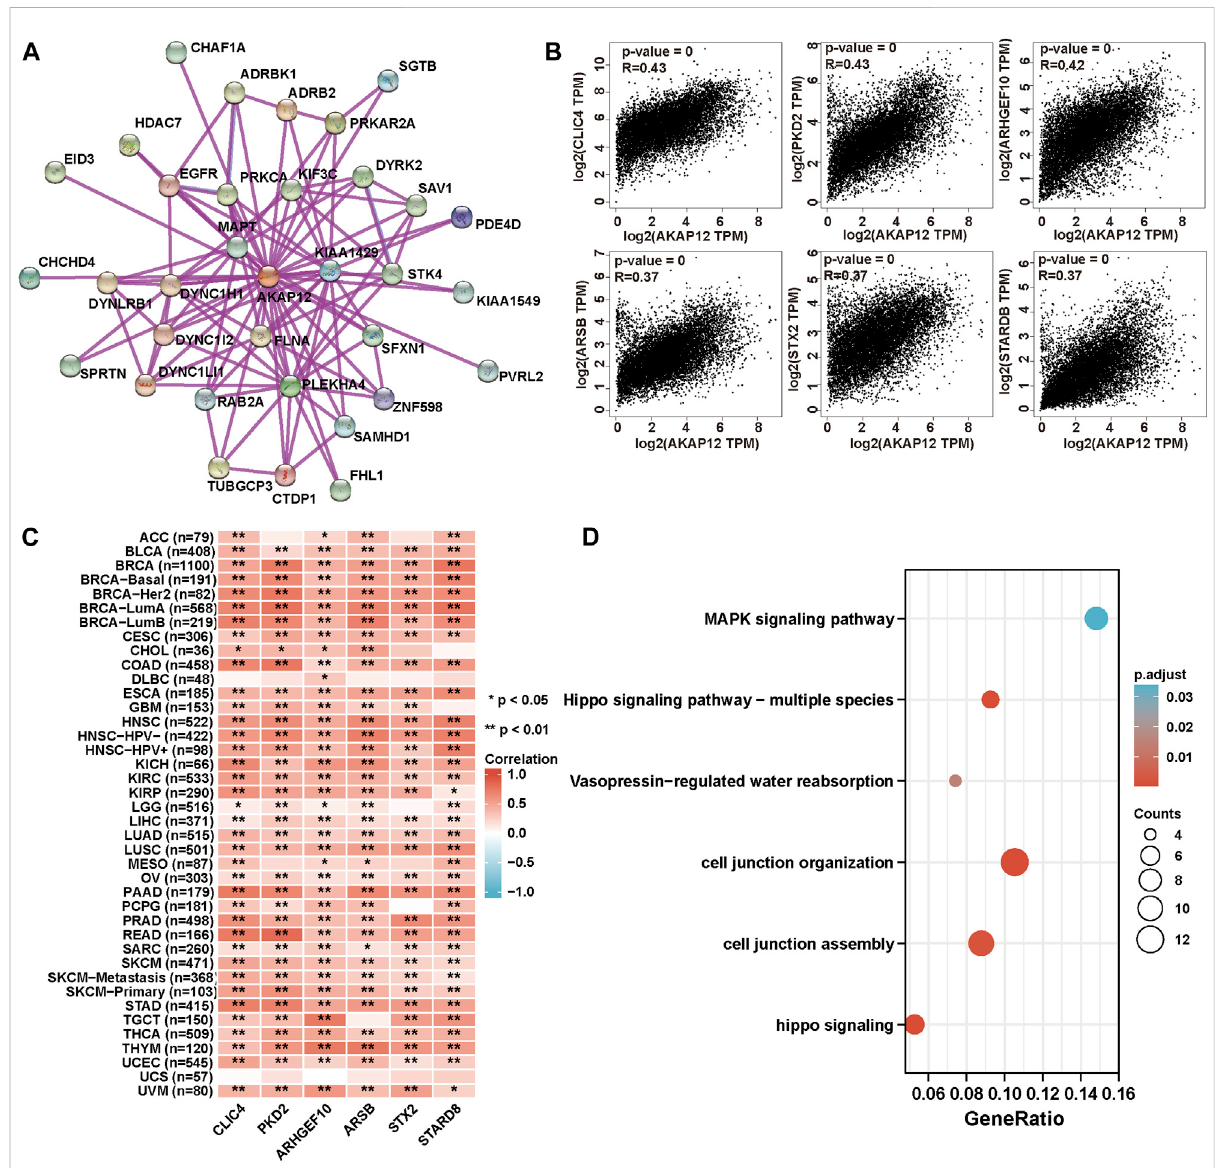
FIGURE 7 AKAP12-related gene enrichment and pathway analysis. (A) Protein network graph of experimentally determined AKAP12-binding proteins generatedusingSTRING.Colorednodesrepresenttheindividualproteinsidenti fi ed. (B) RelationshipbetweenAKAP12expressionandrepresentative genes (CLIC4, PKD2, ARHGEF10, ARSB, STX2, STARD8) of the top AKAP12-related genes within TCGA projects as determined via the GEPIA2 portal. (C) Heatmap representation oftheexpressionassociation betweenAKAP12 and CLIC4,PKD2, ARHGEF10,ARSB, STX2, and STARD8 inall TCGA tumors. (D) GO-KEGG analysis according to the AKAP12-binding and interacted